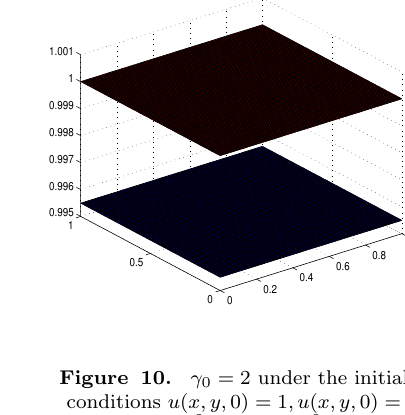
Figure 9. γ 0 = 1 . 6 under the initial conditions (4.1) at t = 8.